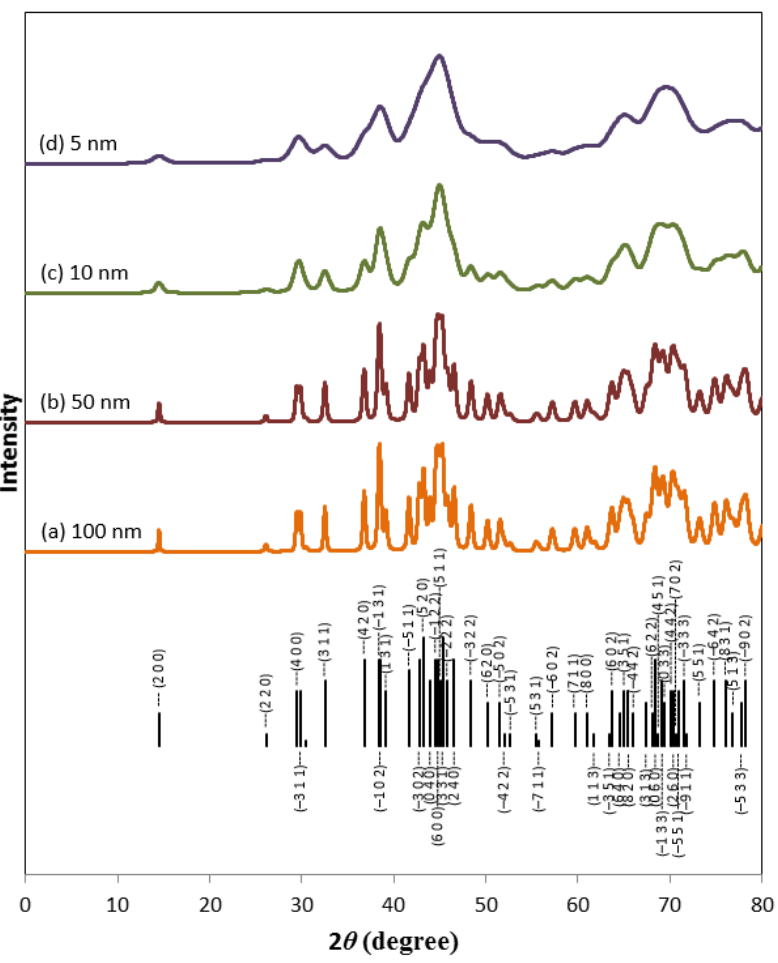
Figure 9. Simulated XRD profile assuming 50% Gaussian and 50% Lorentzian distribution of un-strained crystallite size of 1000 ( a ); 500 ( b ); 100 ( c ); and 50 Å ( d ). The reflections from the Zr 2 Ni 7 phase are labeled at the bottom. Peak positions and intensities are from PDF